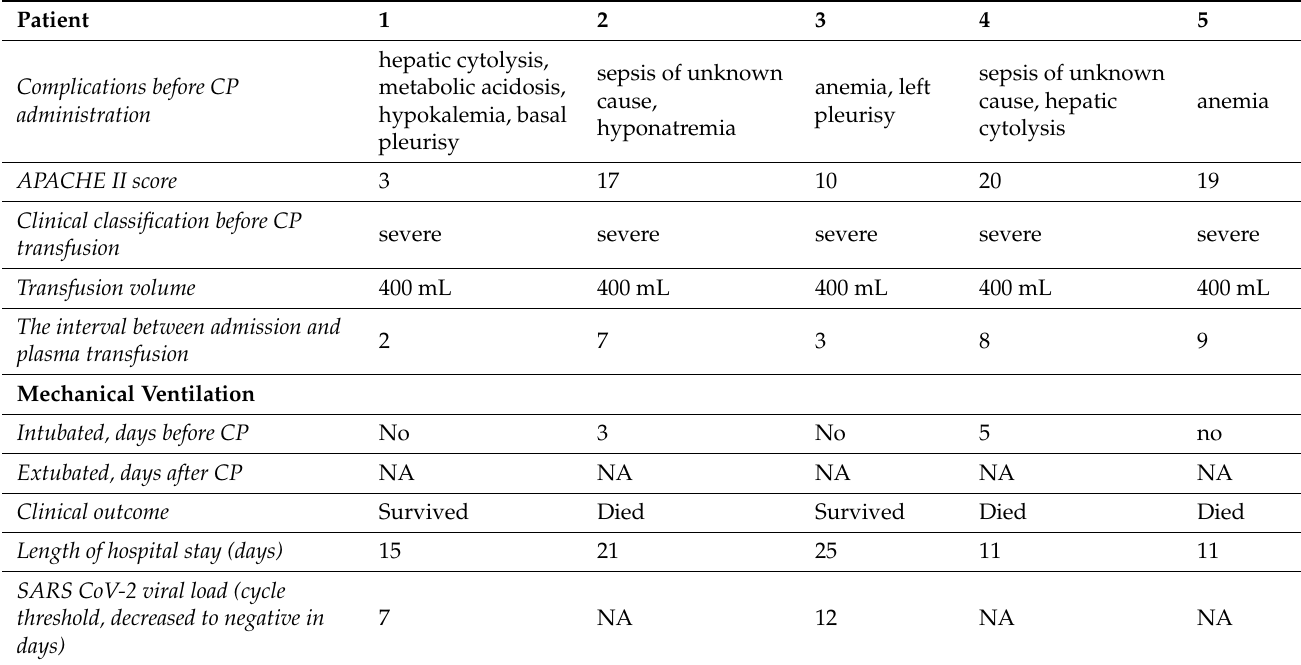
Table 3. Characteristics and outcome of patients treated with CP.